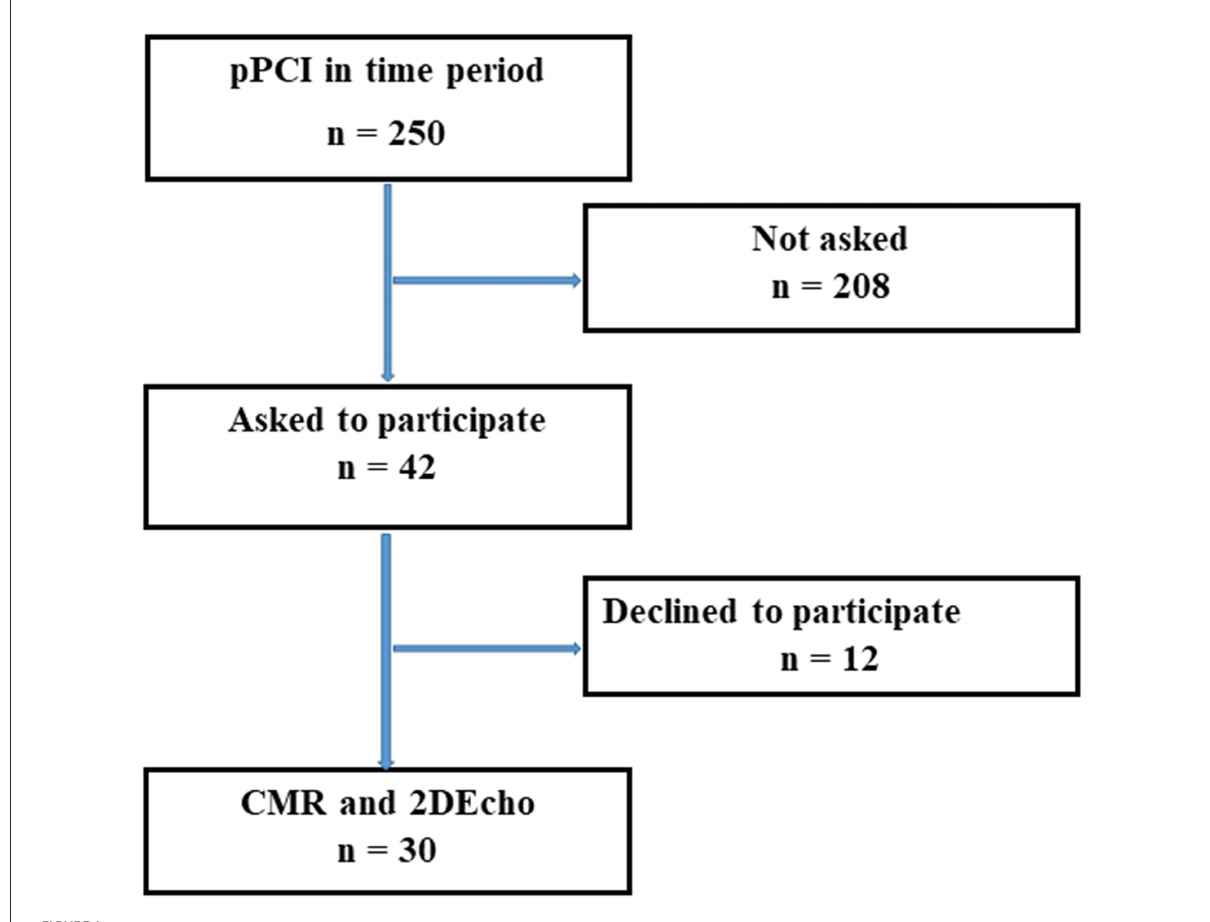
FIGURE1 Flowchart of study